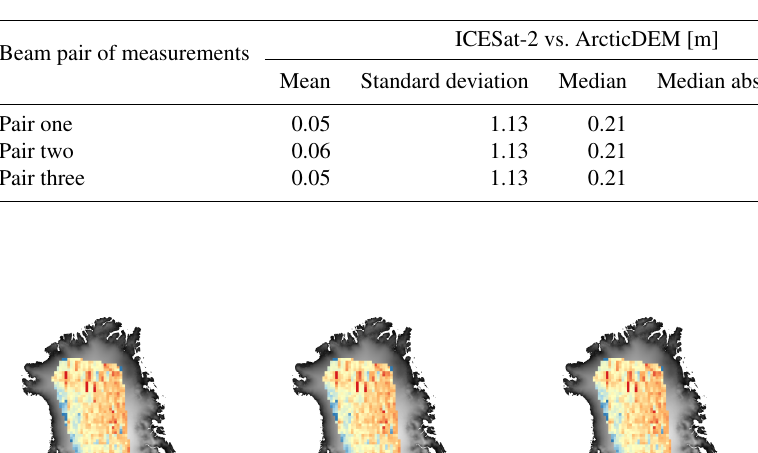
Table A1. Difference between ICESat-2 measurements and ArcticDEM values interpolated to ICESat-2 locations.